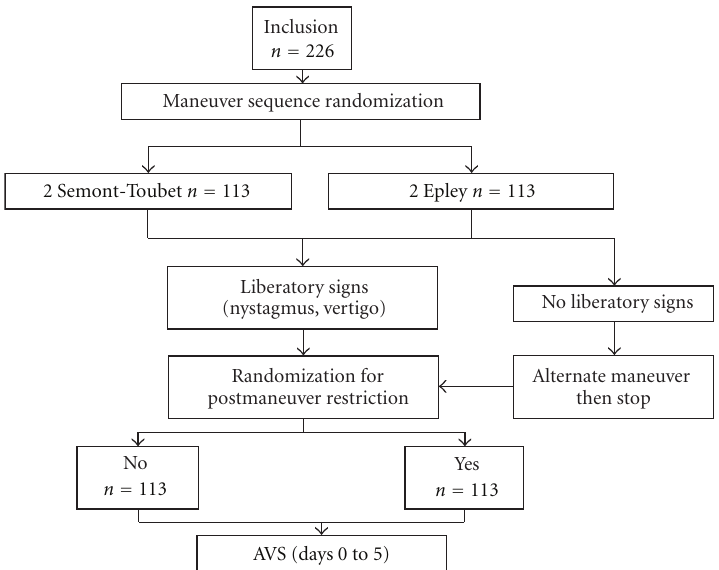
Figure 1: Flow chart of the study: patients were first randomized for Epley and Semont-Toupet maneuver sequences. In each group, a second randomization was performed dividing the patients into 2 subgroups: with or without postmaneuver restrictions.